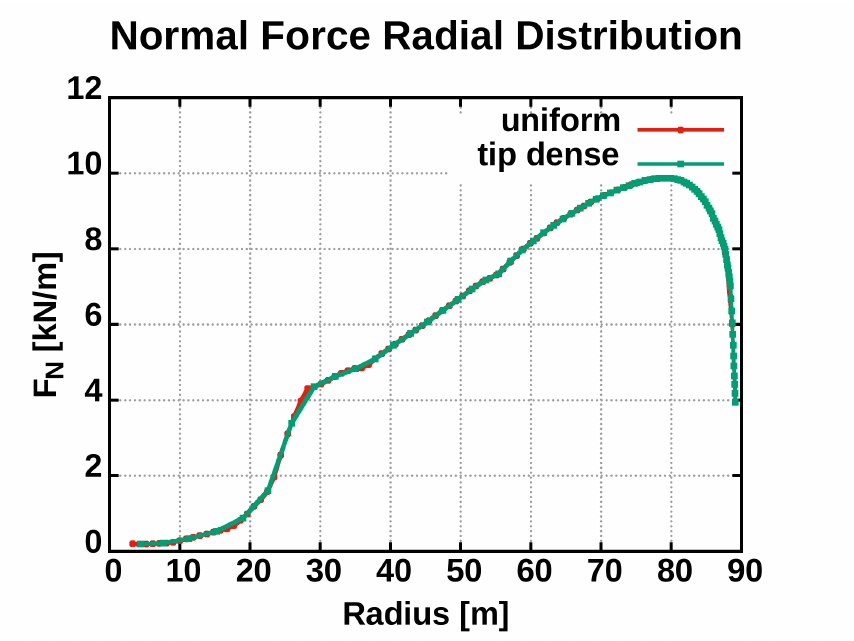
Figure 7. Normal force radial distribution. Comparison of uniform and tip dense distribution of